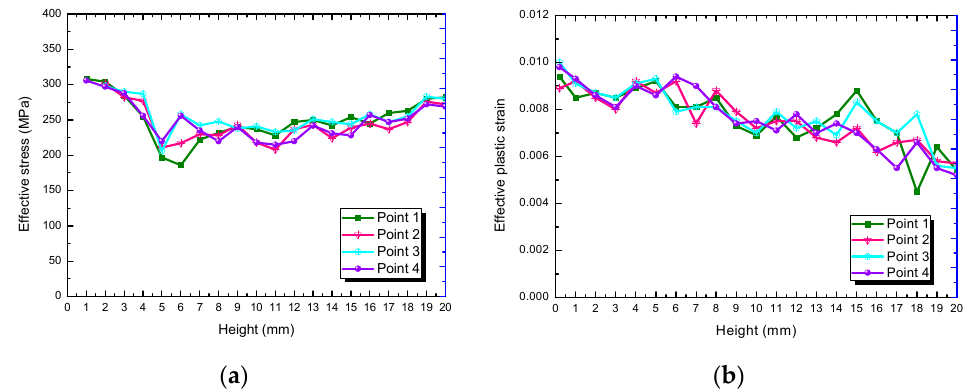
Figure 5. Stress–strain curve from the bottom to the surface of the part. ( a ) Thermal stress; ( b ) thermal strain.